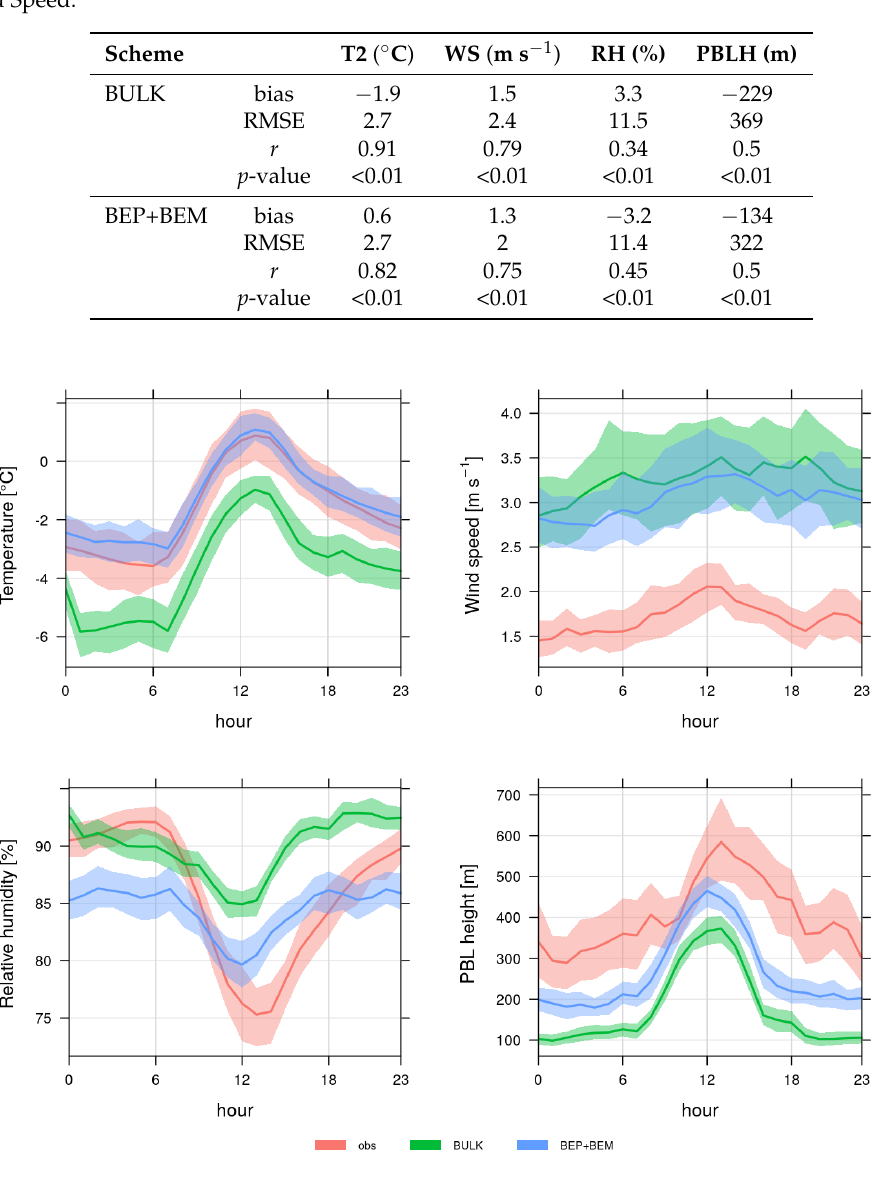
Figure 5. Averaged diurnal profiles of the temperature at 2 m, wind speed, relative humidity, and PBL height for observations (red), BULK simulations (green), and BEP+BEM simulations (blue). Lines represent the mean values and shaded areas the 95% confidence interval in the